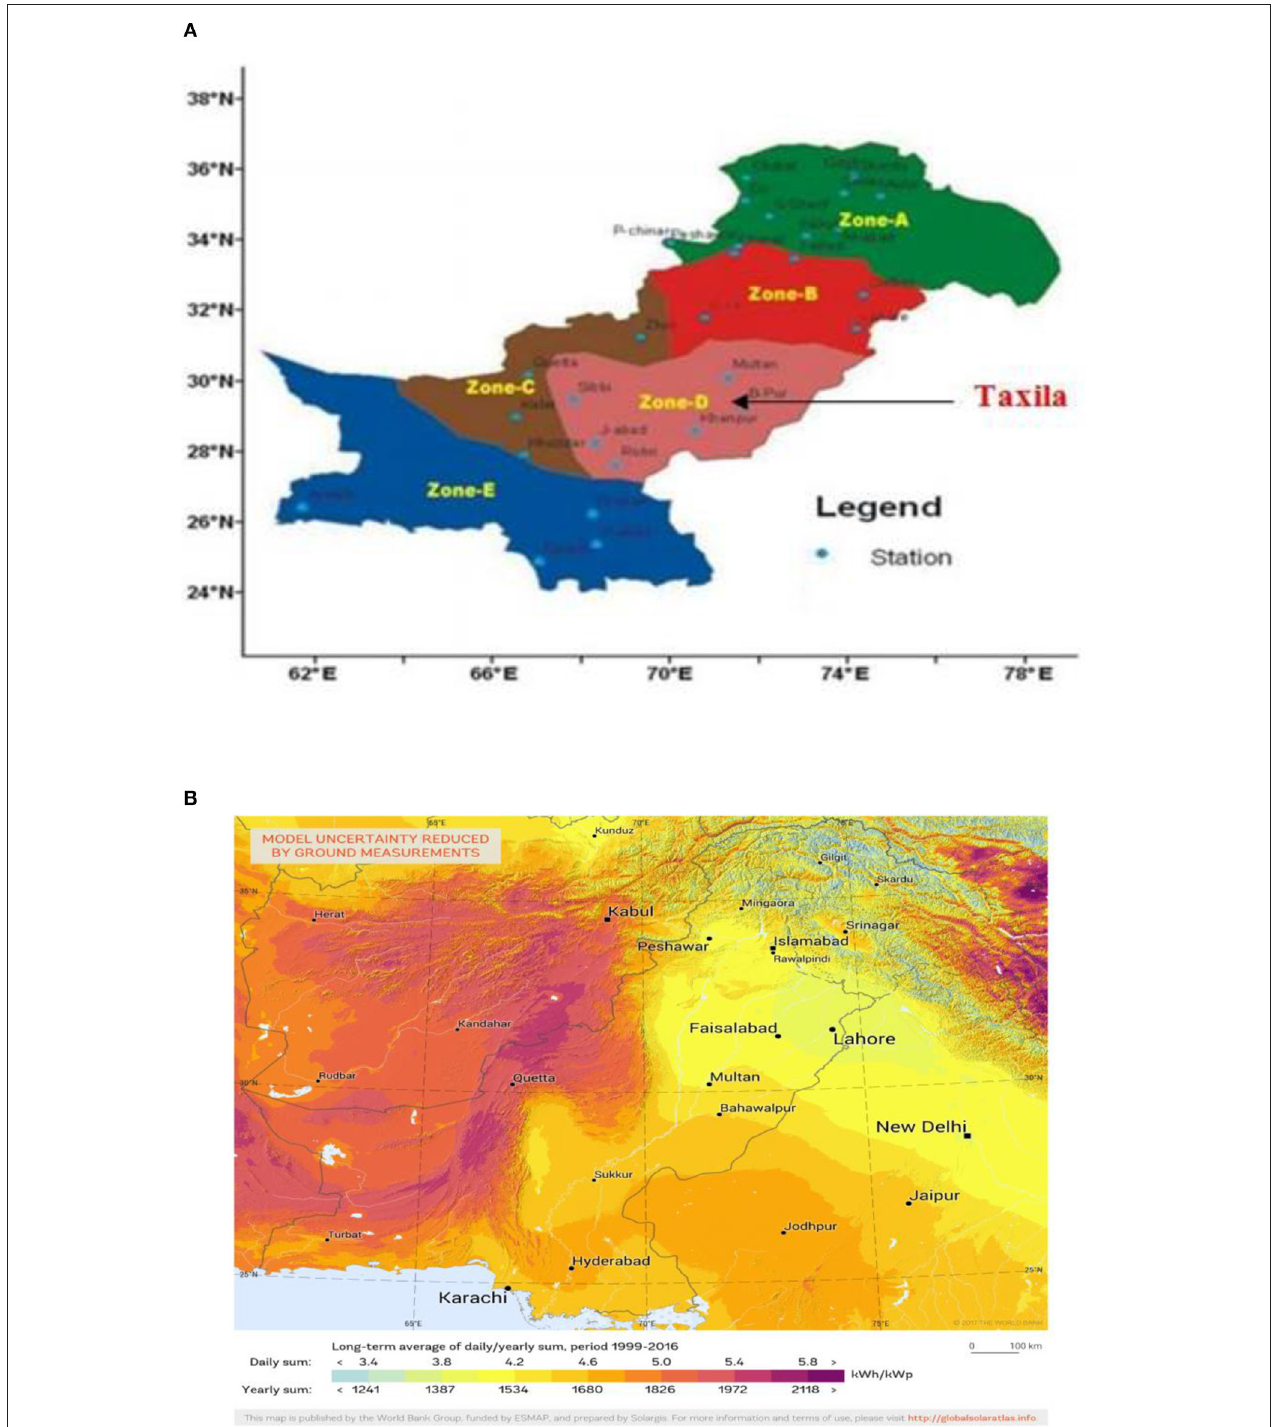
FIGURE 2 | Zones classification of Pakistan. (A) Classification of zones on the basis of climate in Pakistan. (B) Classification of zones on the basis of solar potential in Pakistan. For estimation of sensible and latent heat transfer due